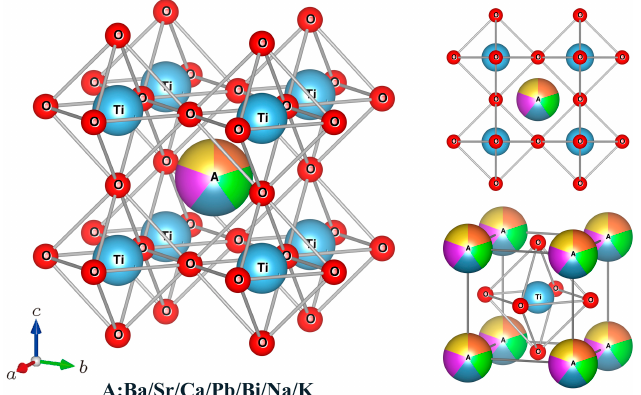
Figure 2. Crystal structure of HEPOs with multiple elements at A-site. The red sphere represents oxygen ion, the blue sphere represents titanium cation at B-site, and the colored ball represents the multi-component cations at A-site.